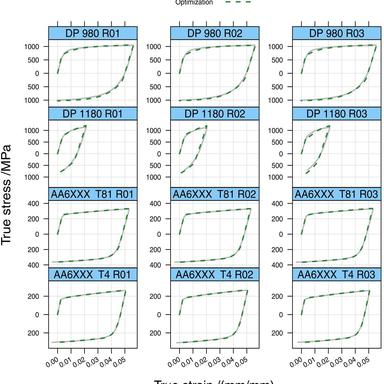
Comparison of measured true stress vs. true strain data and FEA-computed true-stress-true-strain data determined using the Y-U parameters from the Optimization Method for top to bottom: DP 980, DP 1180, AA6XXX-T81, and AA6XXX-T4.